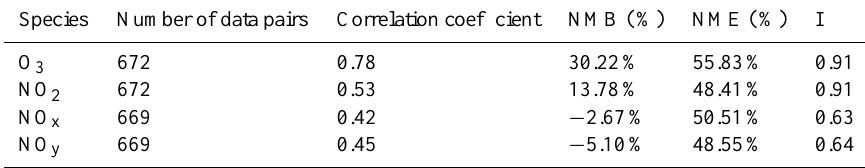
Table 2. Statistical results between CMAQ model and observation data during 5–31 August 2010.